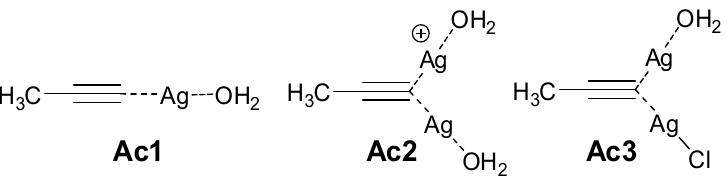
Figure 4. Possible Ag(I)-acetylide intermediates.